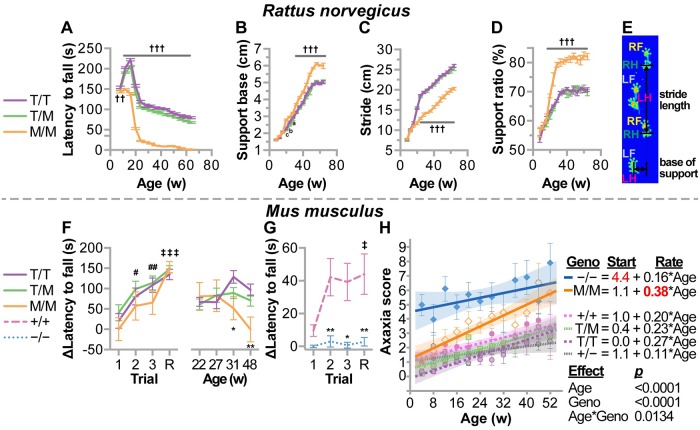
CHIP-T246M in rodents resulted in progressive ataxia and altered gait.Changes in (A) rotatrod performance, (B) support base, (C) stride, and (D) support ratio over time in rats with the indicated genotypes represented by line plot and summarized by the mean ± SEM (N = 6 animals/genotype), Tukey’s post hoc test: a, b, c, and ††† correspond to p < 0.05, 0.01, 0.001, and 0.0001 comparing M/M to T/T and T/M. (E) Graphical representation of gait parameters with foot locations indicated (RH = right hand, RF = right foot, LH = left hand, LF = left foot). (F) Rotarod analysis during the initial learning phase (left) or over time (right) represented by a line graph of the change in latency to fall over the first three trials, including a re-test (R) two days later, summarized by the mean ± SEM (N = 10–20 animals/genotype), Dunnett’s post hoc test: #, ## correspond to p < 0.05, 0.01 within T/T and T/M mice compared to trial 1; ††† p < 0.001 within all three genotypes compared to trial 1; 0.001 compared to previous time point; Tukey’s post hoc test: *, ** correspond to p < 0.05, 0.01 comparing M/M vs. T/T. (G) The initial rotarod performance in CHIP null mice (−/−) or wild-type mice (+/+) over the first three trials, including a re-test (R) two days later, summarized by the mean ± SEM (N = 10 animals/genotype), Tukey’s post hoc test: ‡ corresponds to p < 0.05 compare to trial 1; *, ** correspond to p < 0.05, 0.01 comparing genotypes. (H) Composite ataxia score of mice with the indicated genotypes including wild-type (+/+), heterozygous (+/−), and homozygous (−/−) knockouts of the CHIP allele represented by scatterplot and summarized by the mean ± SEM (N = 12 animals/genotype). Results of the linear regression analysis are depicted by the line and equation provided and results of the mixed model analysis provided. In comparing slopes, only M/M mice had a different slope at α = 0.05.